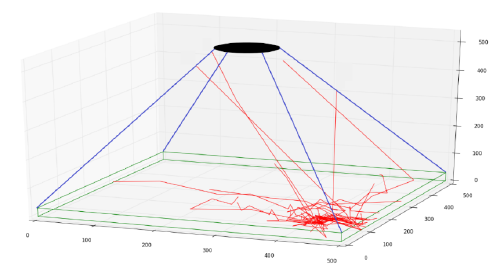
Figure 2. Simulation of particle detection in pyramid shape de- tector